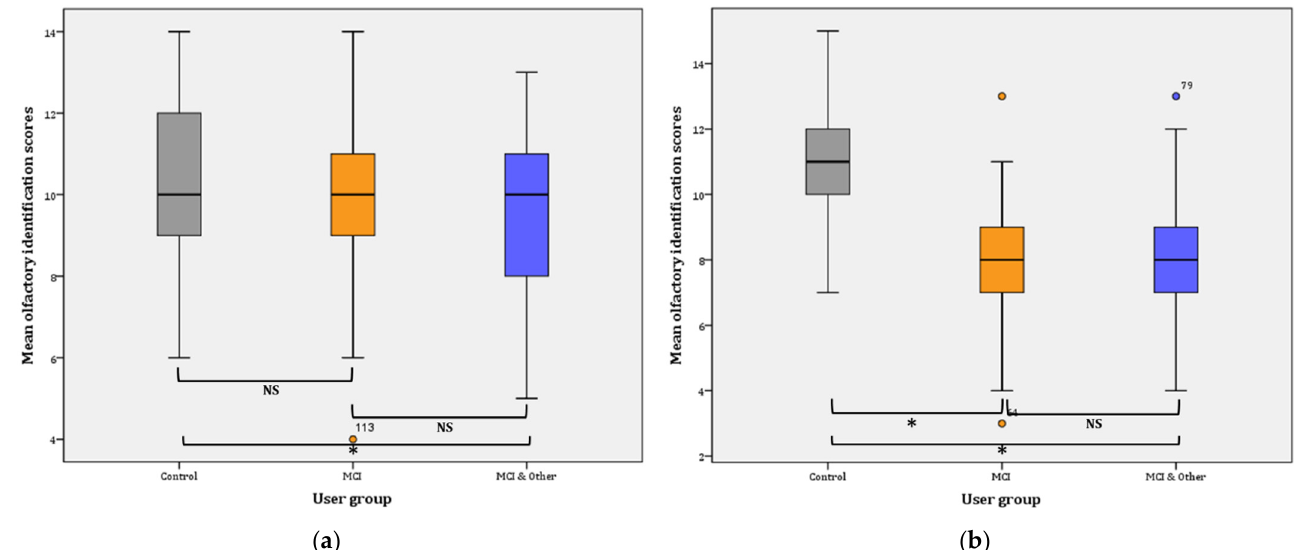
Figure 4. Mean olfactory identification scores: ( a ) for Phase I; for Control–MCI & Other, * p < 0.001. ( b ) for Phase II ; for Control–MCI and Control–MCI & Other, * p < 0.001, NS: